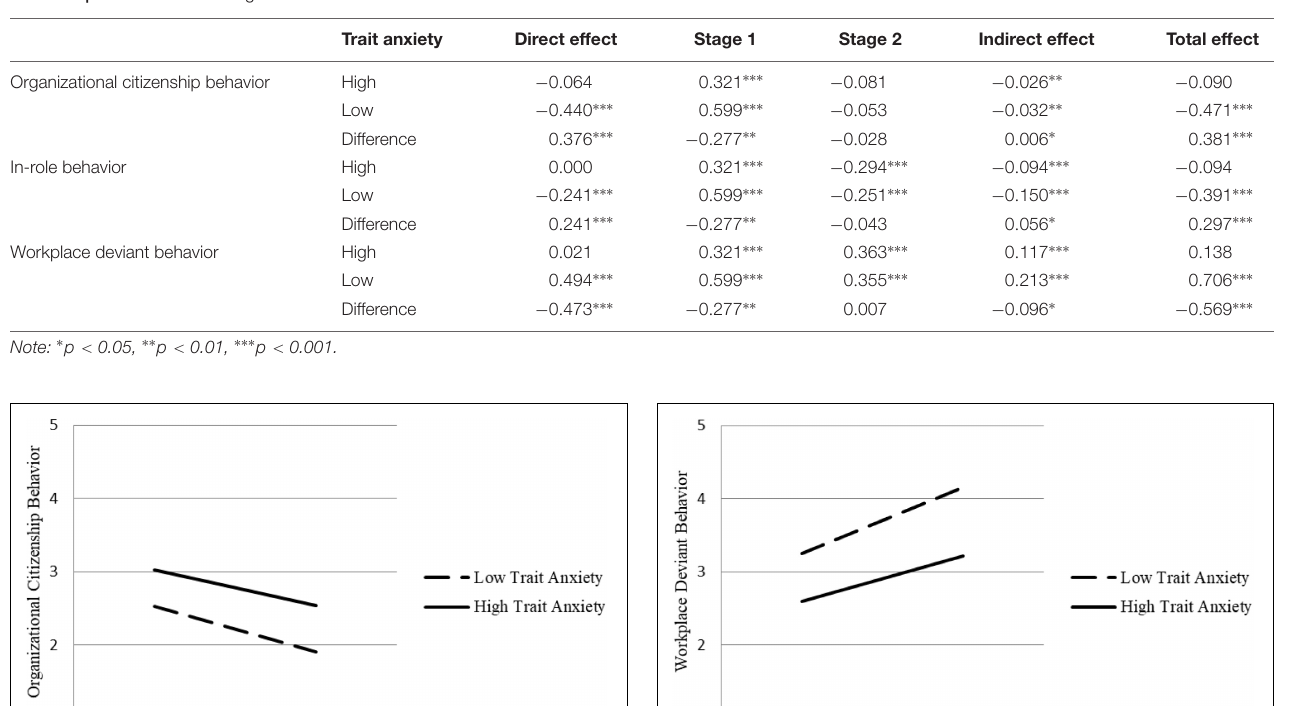
TABLE 4 | Moderated mediating effects.